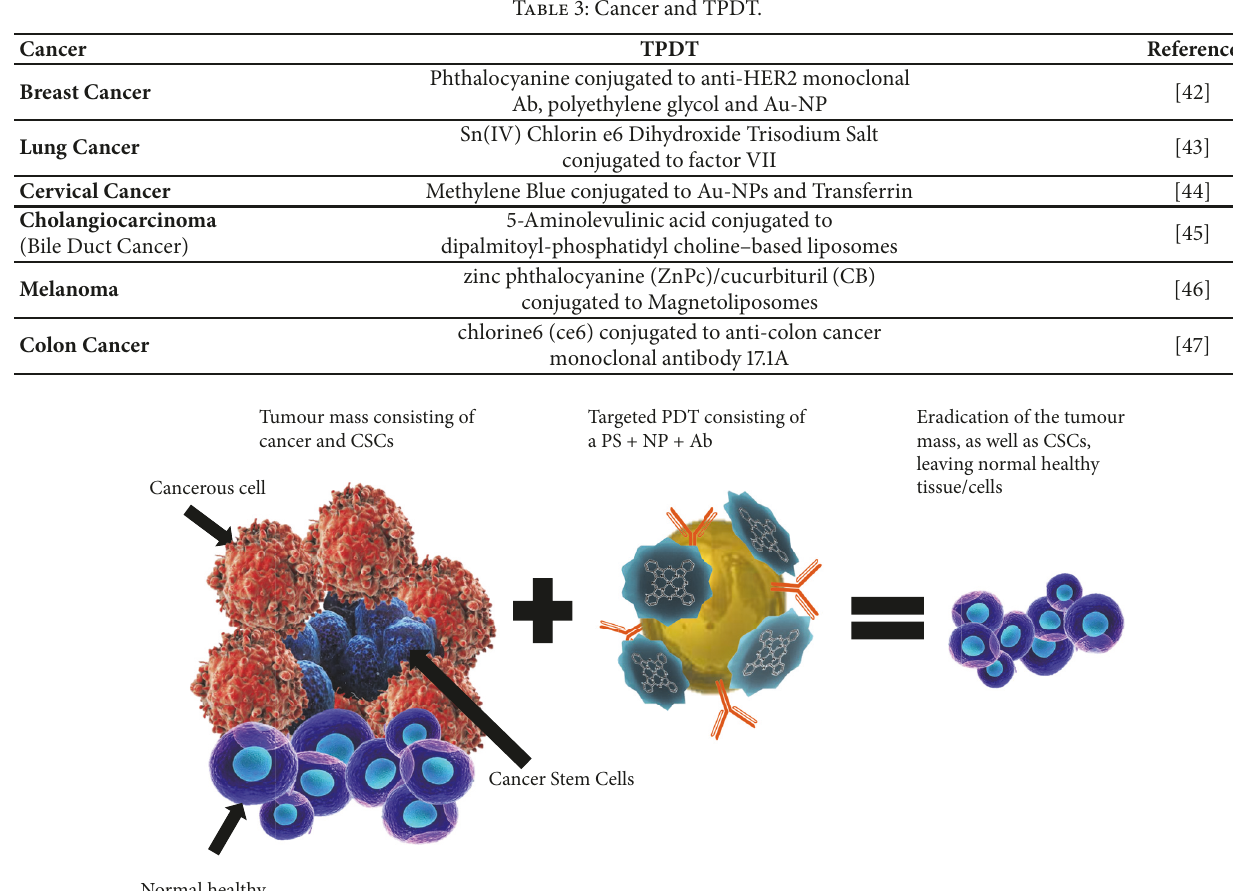
Figure 3: CSCs and targeted PDT using antibodies and nanoparticles. TPDT targeting cancer as well as CSCs, eradicating the entire tumour that advocates for normal healthy tissue